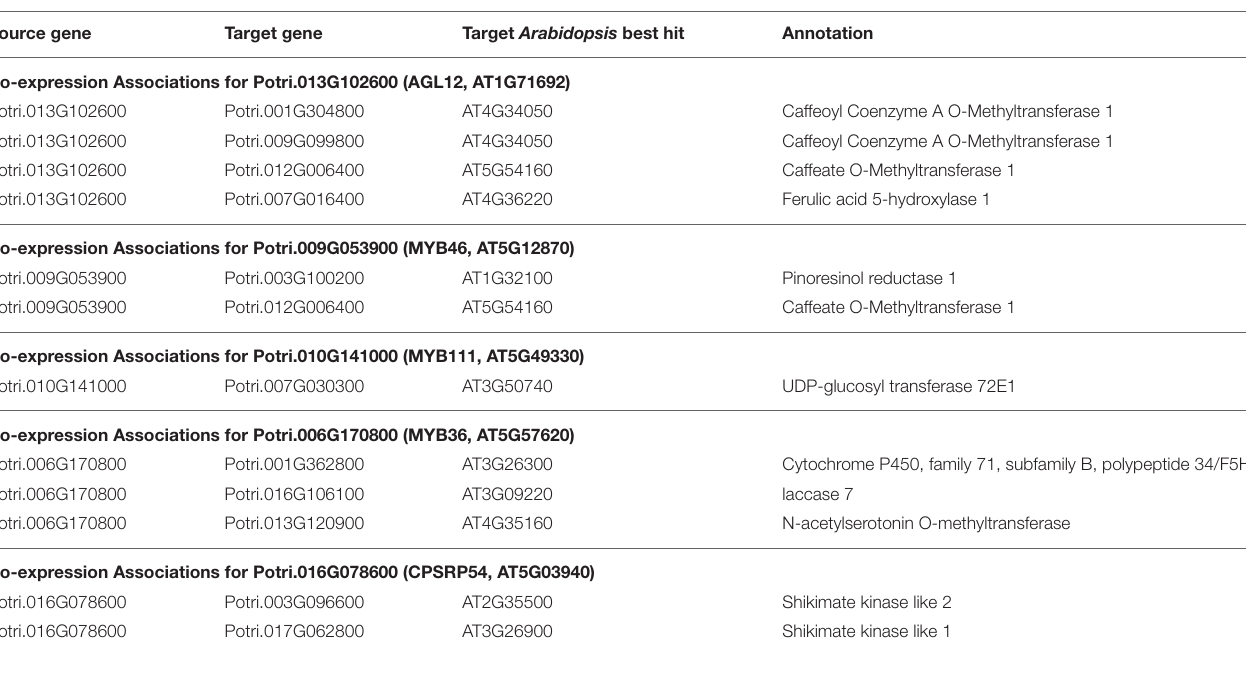
TABLE 2 | Co-expression associations for select new potential target genes. Annotations are derived from best Arabidopsis hit descriptions, GO terms and in some cases MapMan annotations. Source gene Target